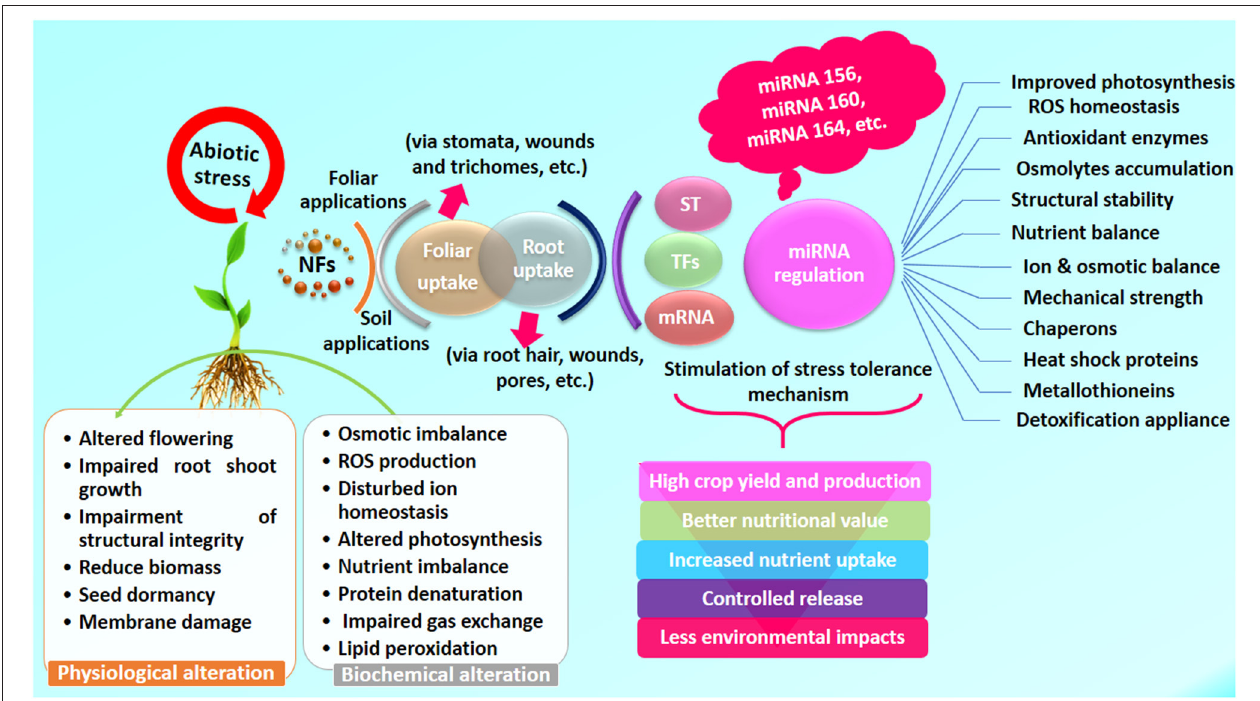
FIGURE 2 | An overview of benefits of NFs to enhance mitigating abilities of plants under environmental stress conditions. ST, signal transduction; TFs, transcription